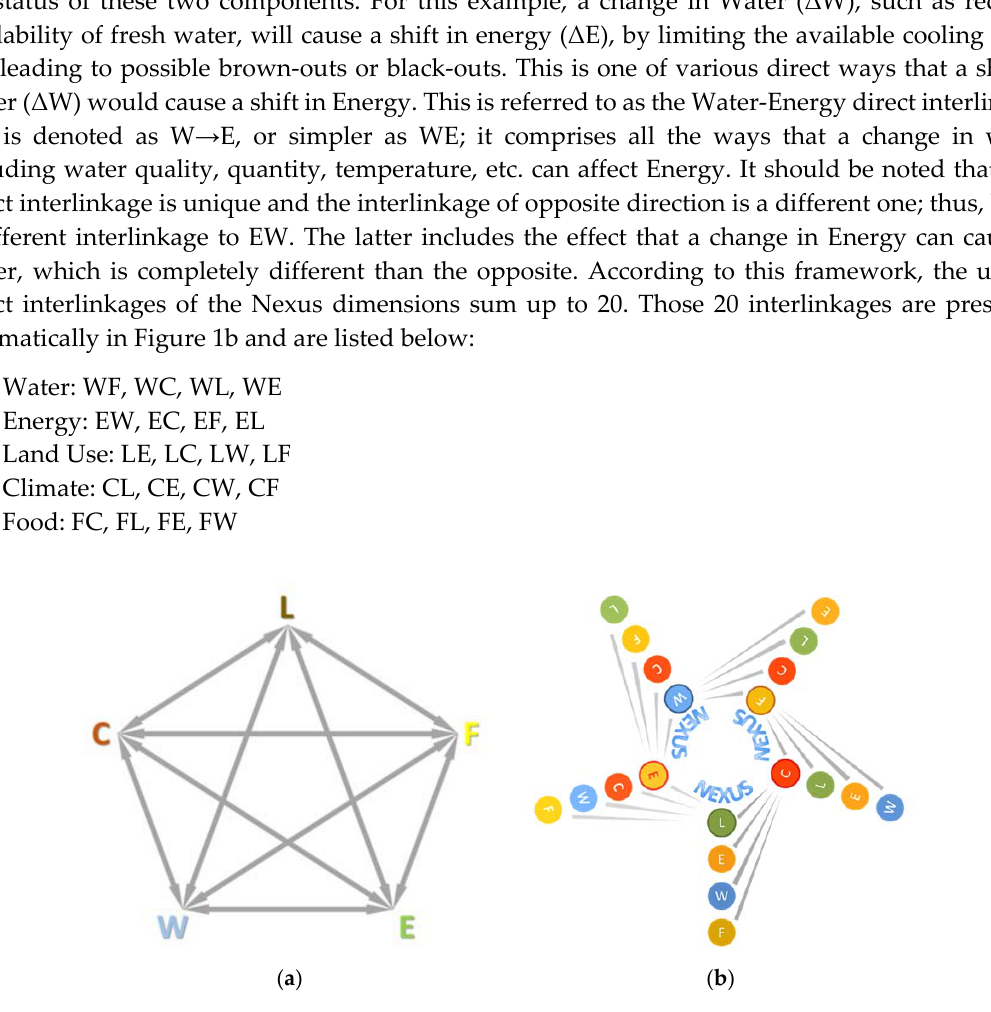
Figure 1. ( a ) Nexus component interlinkages, showing all interrelations between different Nexus components; ( b ) Schematic of Nexus component interlinkages, showing how each one of the five Nexus components relate to the other